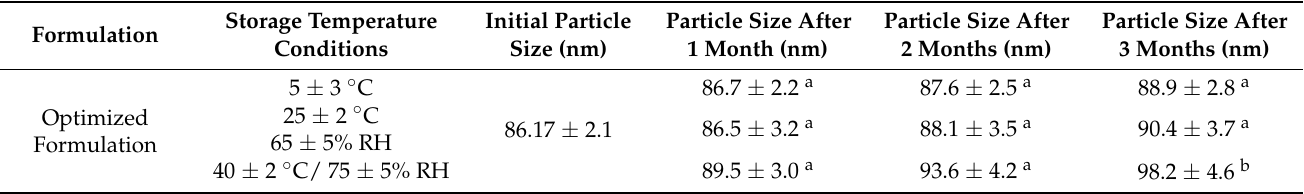
Table 3. Physical stability evaluation of the bergenin loaded nanosuspension.